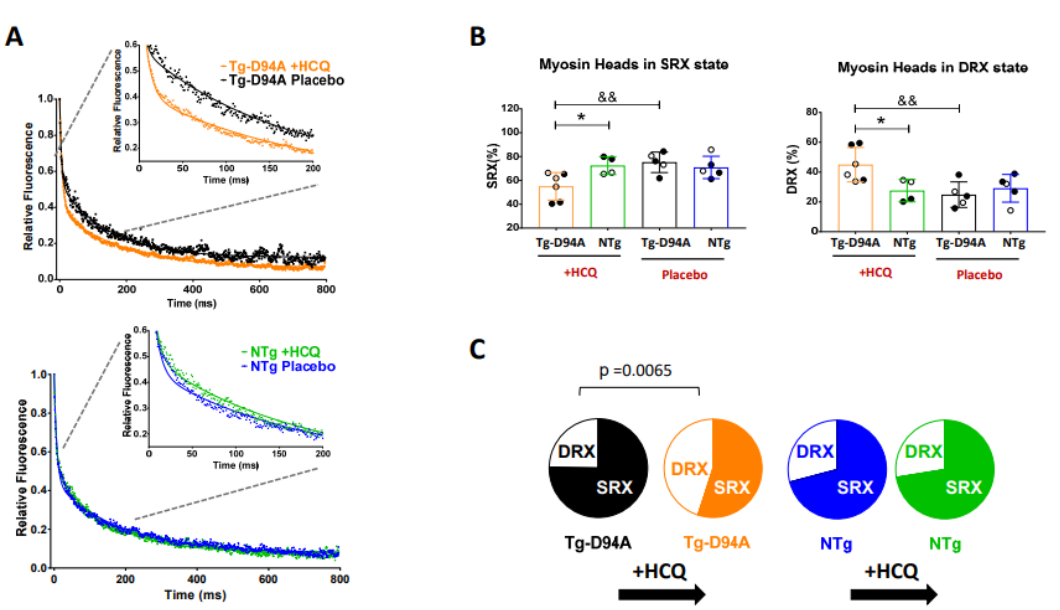
Figure 8. Effect of HCQ treatment on the distribution of myosin energetic states in Tg-D94A vs. NTg hearts. ( A ) Mant-ATP turnover studies and the comparison of fluorescence decay curves between HCQ- vs. placebo-treated Tg-D94A ( upper panel) and between HCQ- vs. placebo-treated NTg mice ( bottom panel). ( B ) Comparison of myosin heads in the SRX state ( left panel) and DRX state ( right panel). LVPM fibers from HCQ-treated Tg-D94A (3 males, 3 females) were compared with HCQ- treated NTg (2 males, 2 females), and placebo-treated Tg-D94A (3 males, 2 females) were compared with placebo-treated NTg (3 males, 2 females). Open symbols depict female mice, and closed symbols depict male mice. Note that % SRX is decreased in HCQ-treated Tg-D94A vs. NTg mice, and this effect is coupled with increased DRX in HCQ-treated Tg-D94A vs. NTg mice. Significant changes were noted in the SRX/RDX distribution for HCQ vs. placebo-treated Tg-D94A animals. Data points represent averaged values from 11–17 fibers/per heart and are expressed as the mean ± SD of n = N o animals with significance calculated using two-way ANOVA followed by Sidak’s multiple comparison test. * p < 0.05 for HCQ-treated Tg-D94A vs. NTg mice and && p < 0.01 for HCQ- vs. placebo-treated Tg-D94A mice. ( C ) Pie plots representing the effect of HCQ on the distribution of DRX vs. SRX states in Tg-D94A and NTg hearts. Note the significant effect of HCQ causing a decrease in the number of myosin heads occupying the SRX state while increasing the DRX heads in Tg-D94A mice ( p = 0.0065). No effect of HCQ was observed in NTg